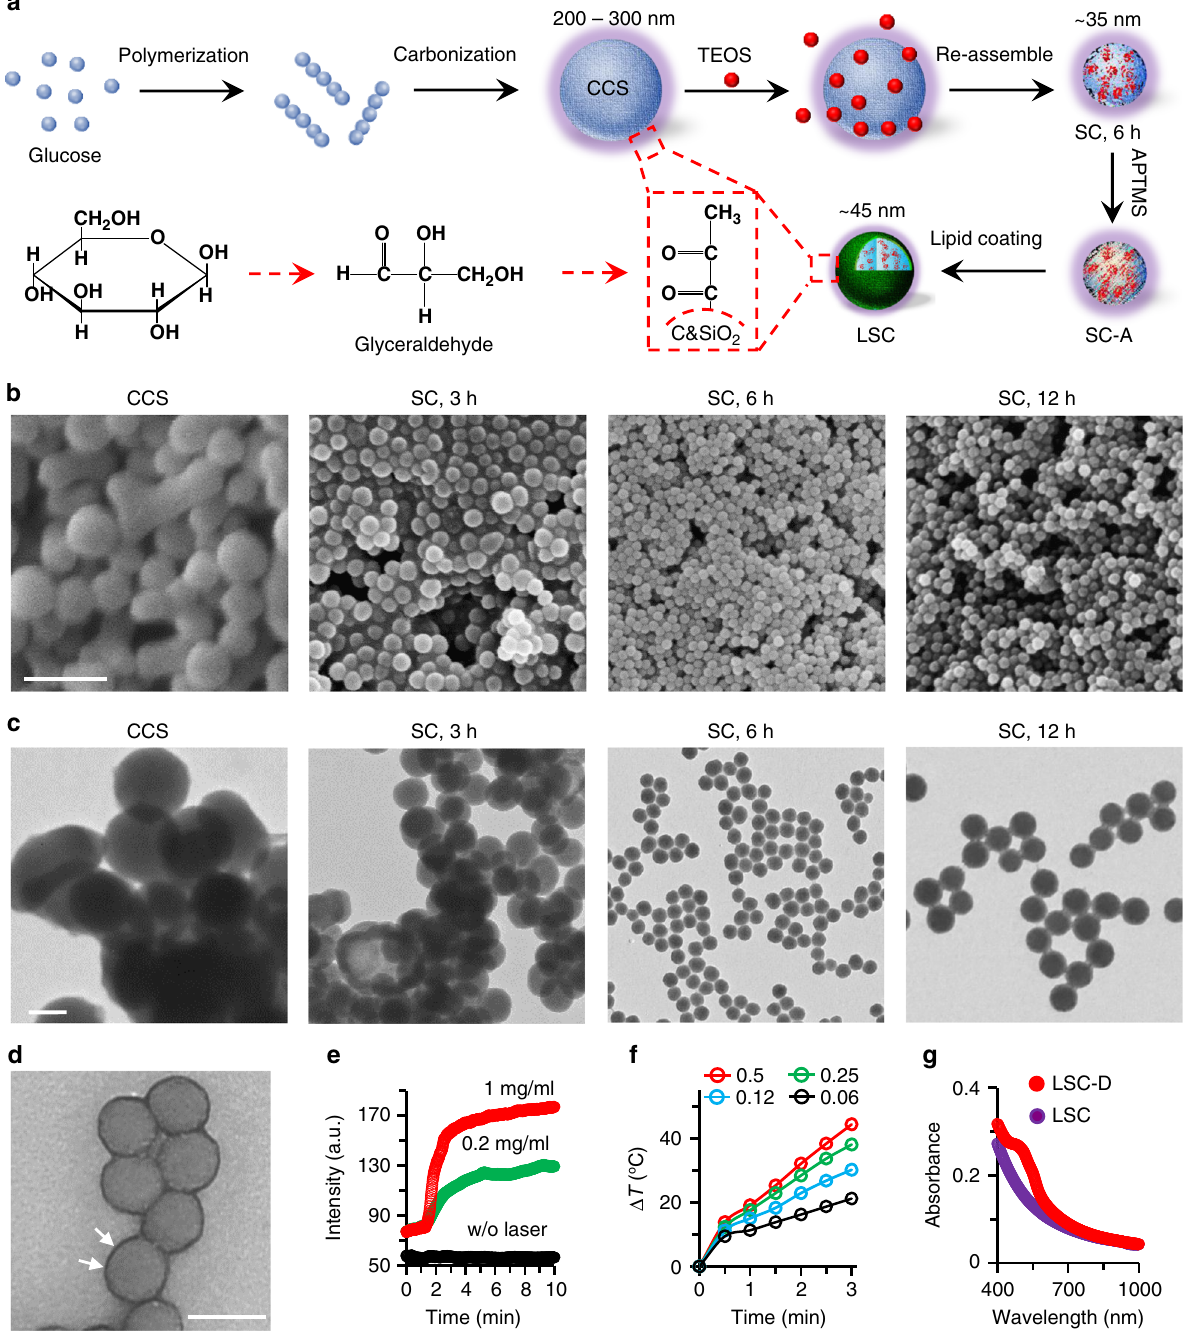
Fig. 2 Synthesis and characterization of nanoparticles. a A schematic illustration of the procedure for preparing colloidal carbon sphere (CCS) nanoparticles using glucose, producing silica-carbon (SC) nanoparticles using the CCS and tetraethyl orthosilicate (TEOS), modifying the SC nanoparticles with (3- Aminopropyl) trimethoxysilane (APTMS) to form SC-A nanoparticles, and coating the SC-A nanoparticles with phospholipid dipalmitoylphosphatidylcholine (DPPC) to produce LSC nanoparticles. The pyruvate group can be formed during the hydrothermal process. b , c